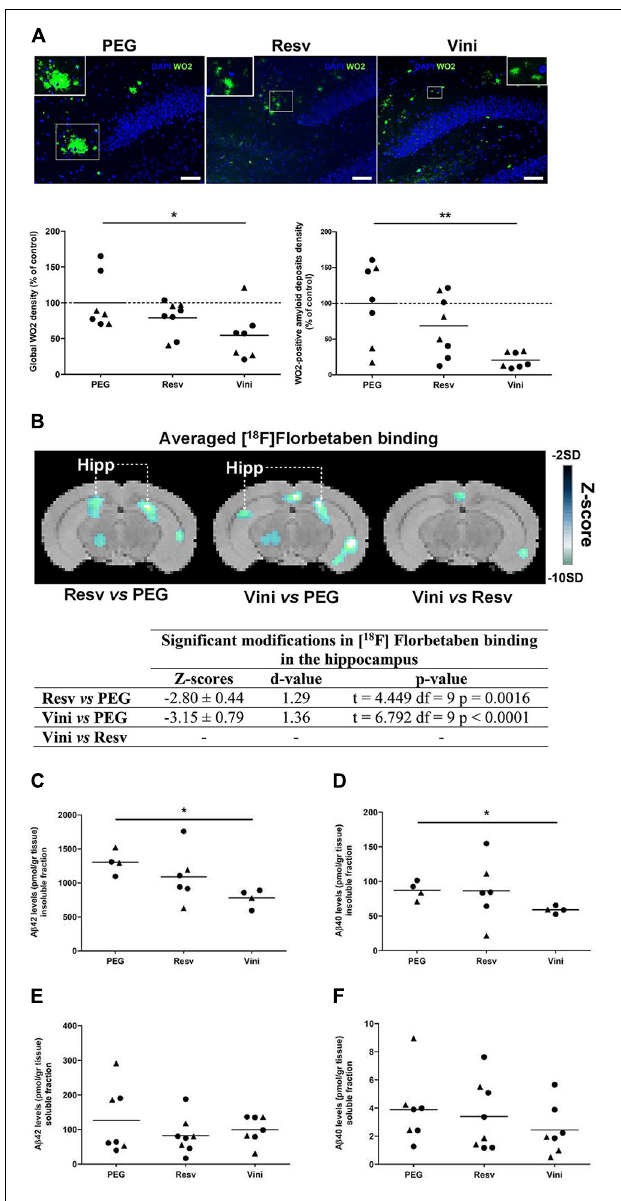
FIGURE 1 | Effects of resveratrol and viniferin on the hippocampal amyloid deposits. The double transgenic APPswePS1dE9 mice were intraperitoneally treated with resveratrol, trans ε -viniferin or their vehicle (PEG 200) at 20 mg/kg/week from 7 to 11 months of age. (A) The senile plaques were stained with antibody against amyloid peptide (clone WO2, green) and the nuclei with DAPI (blue). On each image, a magnification delineated by a white frame was added. Scale bars: 50 µ m. The quantification of global signal WO2 and of WO2-positive amyloid deposits were represented. (B) Coronal images of significant differences in [ 18 F]Florbetaben binding (z-score maps; decreases in tracer binding from dark to white; Student unpaired t -test; p < 0.01) in AD mice fused with an MRI template in three conditions: from left to right Resv vs. PEG, Vini vs. PEG, and Vini vs. Resv. Table resuming the statistical differences in [ 18 F]Florbetaben binding for the three treatment conditions. The z-score and d -value are presented for each significant difference observed along with the t , df, and p values of the unpaired t -test. Hipp, hippocampus; PEG, polyethylene glycol 200; Resv, trans -resveratrol; Vini, trans ε -viniferin. (C–F)